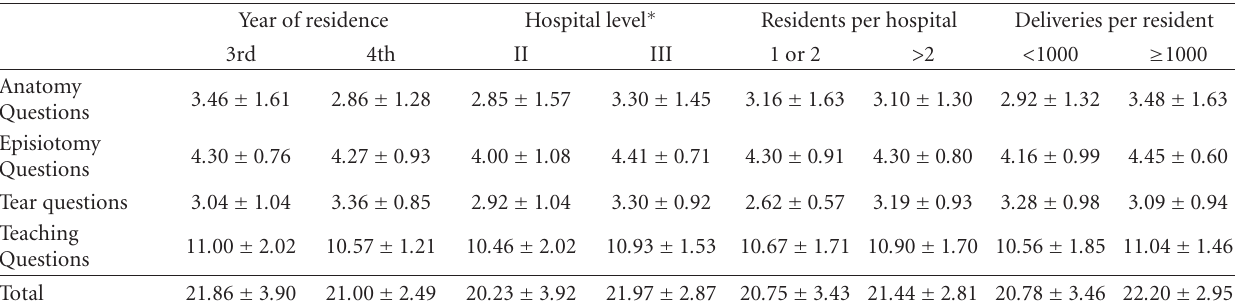
Table 3: Mean scores per block. Higher scores indicate better results (mean ± SD). There were no significant di ff erences in anatomy, knowledge of episiotomy, or knowledge of perineal tears between 3rd and 4th year residents, residents from di ff erent hospital levels, number of residents per hospital, or number of deliveries per resident. ∗ Level III hospitals are referral